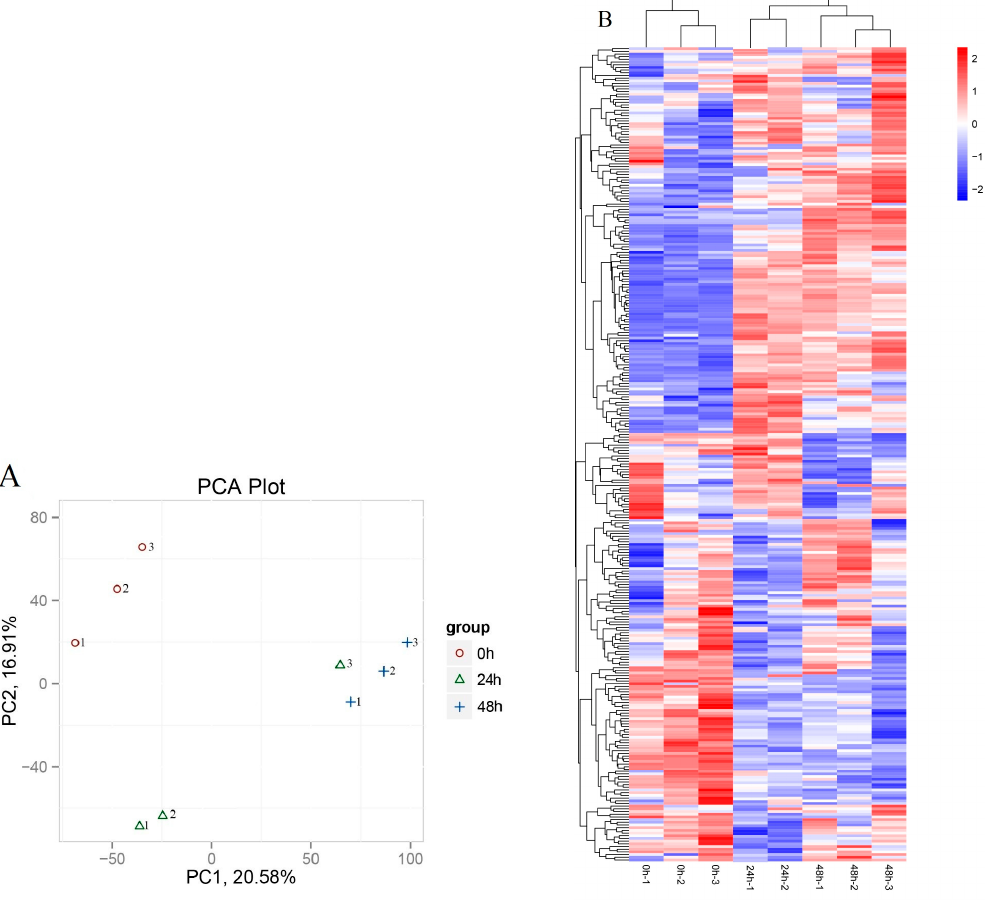
Figure 3. Principal component analysis (PCA) and heat map of lncRNAs during the different drought stages. ( A ) PCA of lncRNAs during different drought stage. x-axis is the contribution rate of the first principal component to the sample difference, y-axis is the contribution rate of the second principal component to the sample difference. 0 h and 48 h samples clustered together, but h24–3 does not cluster with its replicates; ( B ) A hierarchical clustered heat map showing the log 10 transformed expression values for differently expressed lncRNAs between 0 h, 24 h and 48 h. Red represents higher expression and blue represents lower expression. 0 h, 24 h and 48 h indicate that the samples were treated under drought stress for 0 h, 24 h and 48 h, respectively.